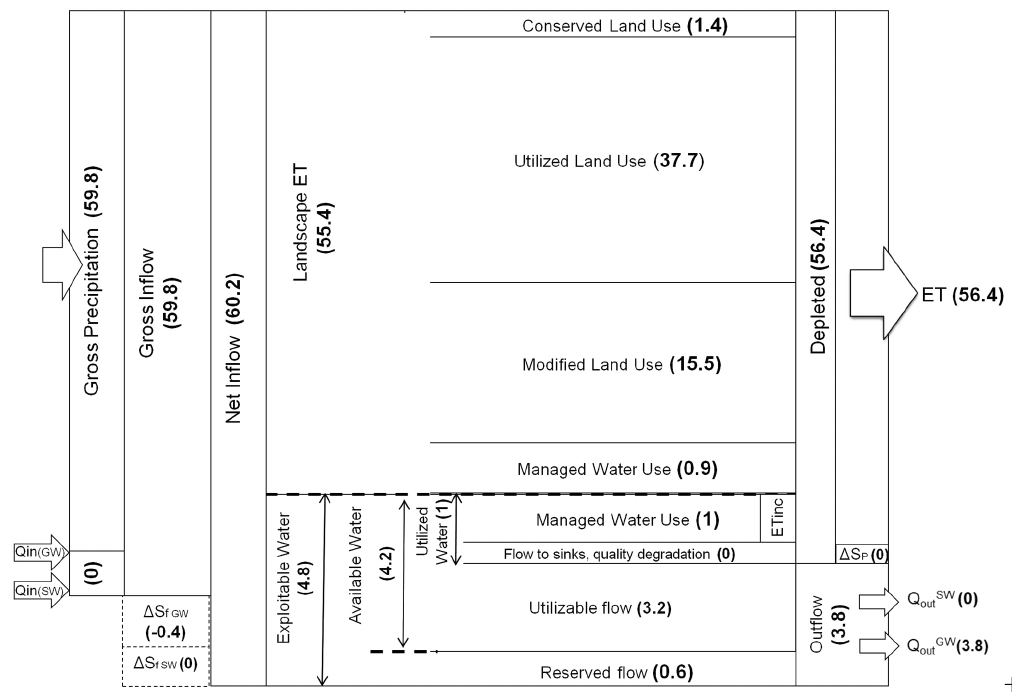
Figure 7. Resource base sheet of